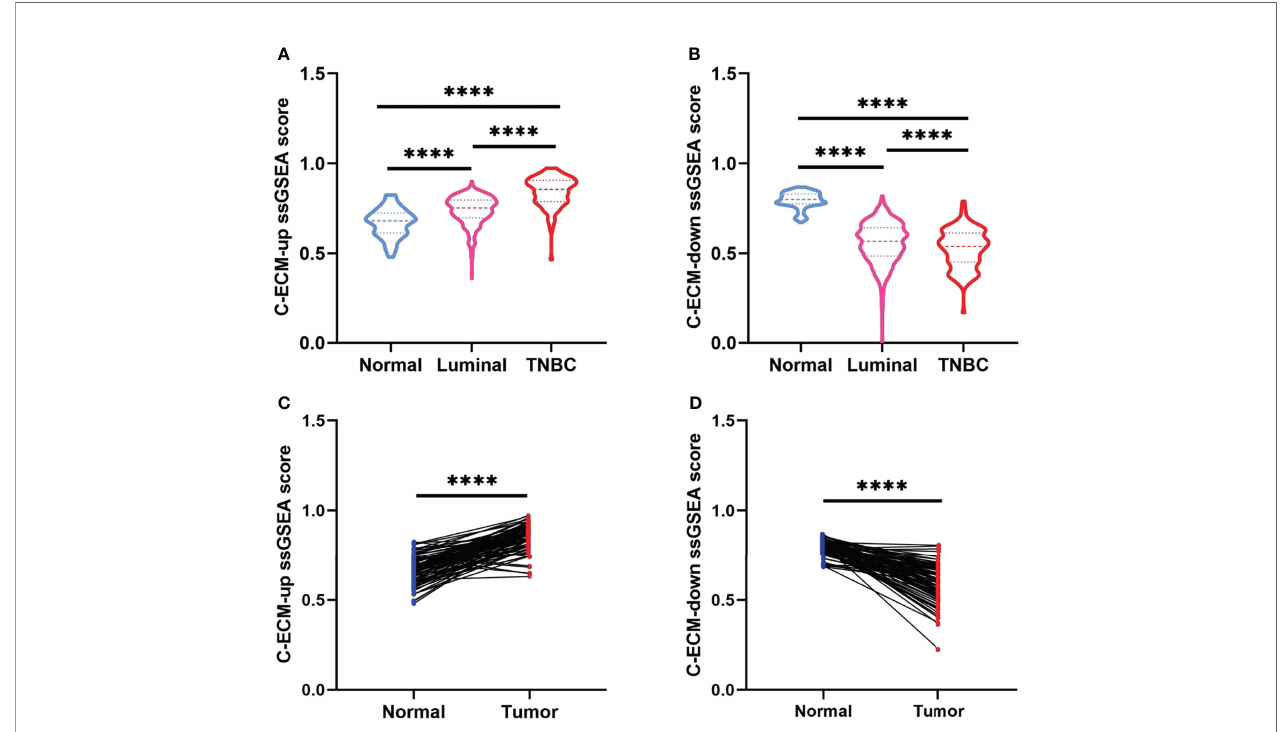
FIGURE 2 | C-ECM dysregulation is associated with the prognosis of breast cancer in TCGA database. (A) C-ECM-up ssGSEA scores of normal, luminal, and triple negative (TNBC) breast cancer tissues in TCGA database. (B) C-ECM-down ssGSEA scores of normal, luminal, and TNBC breast cancer tissues in TCGA database. (C) C-ECM-up scores of paired paracancerous and cancer tissues of breast cancer patients in TCGA database. (D) C-ECM-down scores of paired paracancerous and cancer tissues of breast cancer patients in TCGA database. **** P <